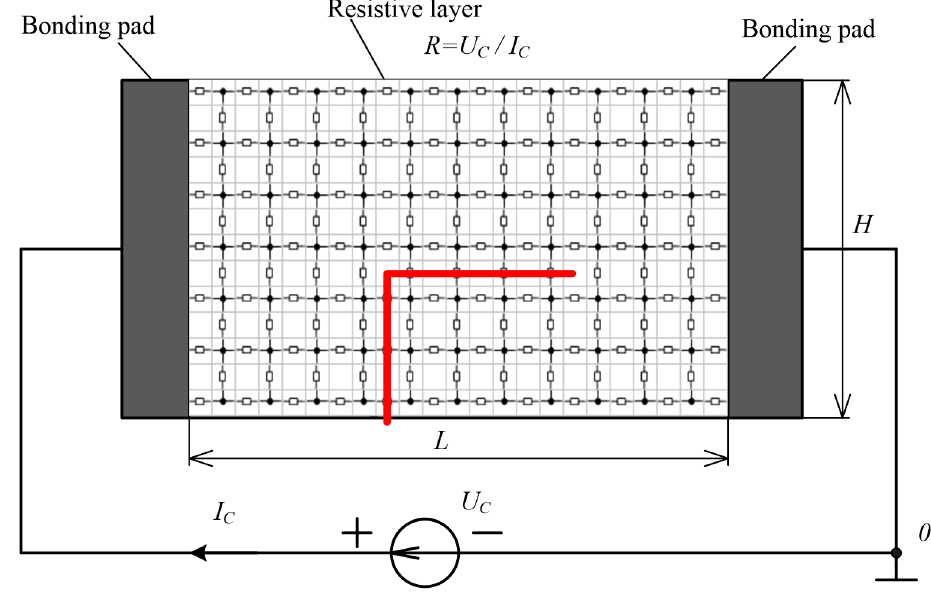
Figure 2. Resistive element model with measuring voltage source and laser trim.